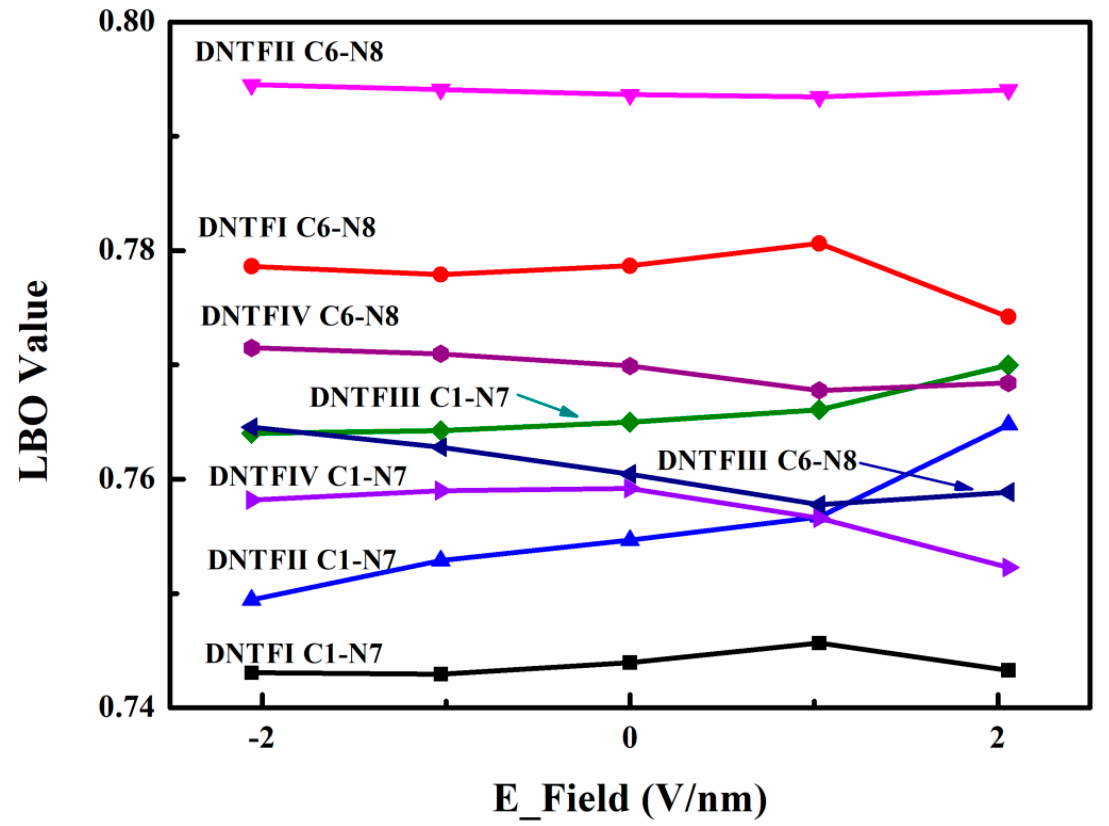
Figure 4. The LBO value of C-NO 2 bonds in the DNTF system under different E-fields. The highest occupied molecular orbital (HOMO) and the lowest unoccupied